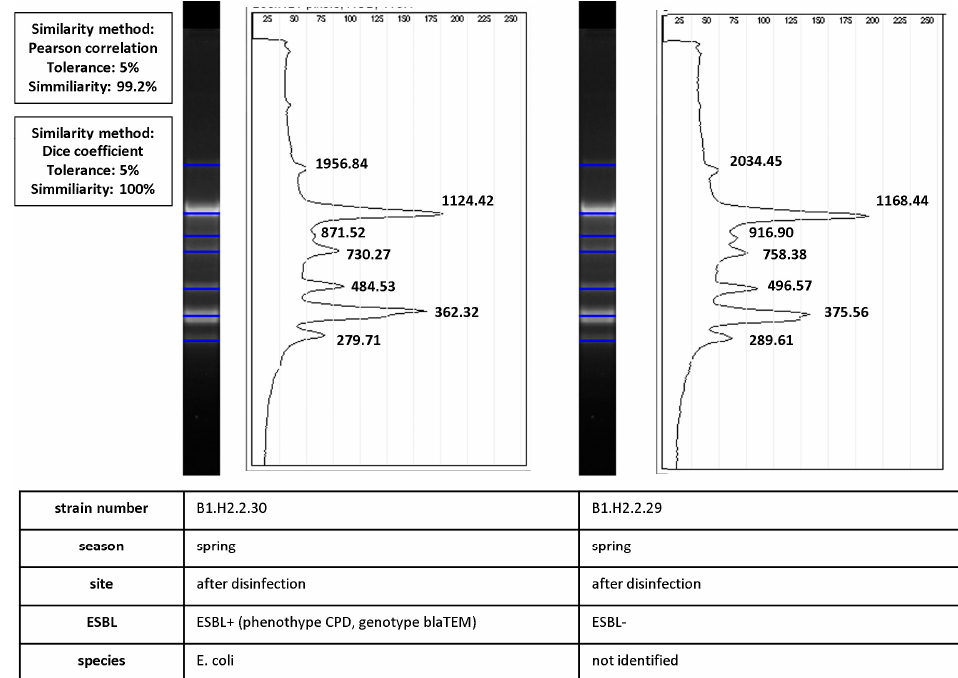
Figure 6. Calculation of similarity values between pairs of ERIC-PCR fingerprints of ESBL+ and ESBL − isolates (isolate characteristics are presented in the table under the diagrams). Band positions were matched by automated band calling in GelJ 1.0. The Dice coefficient (100%) was calculated for match/mismatch data. The line graph shows the intensity of ethidium bromide fluorescence along normalized migration distances for the two fingerprints. Pearson’s correlation coefficient (99.2%) was calculated from intensity values. The black line is the densitometric curve for fingerprints with product band size values (bp).